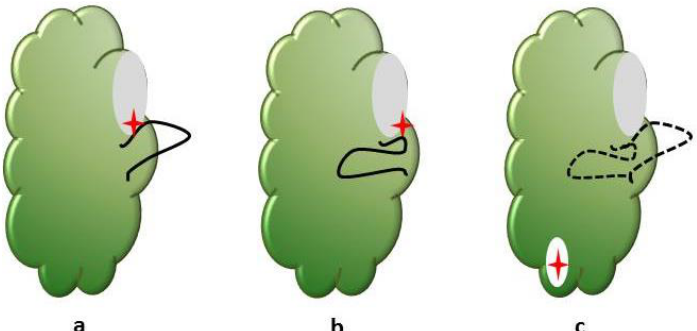
Figure 1. The activation loop of the protein kinase domain regulates access to the ATP binding site. The conformation of a conserved Asp-Phe-Gly (DFG) motif within the activation loop is used to categorize the binding mode of inhibitors. The common types of kinase—kinase inhibitor interactions include: ( a ) Type I inhibitors ( red star) bind the ATP binding site (grey) of the protein kinase domain (green). The aspartate side chain in the conserved DFG motif at the beginning of the activation loop (black) faces into the active site; ( b ) Type II inhibitors bind a flipped conformation of the DFG motif in which the aspartate side chain faces outwards; ( c ) Allosteric ligands bind to binding pockets (white) that do not overlap with the active site of the kinase. The DFG motif conformation is not important. These binding pockets can be adjacent to the active site or distant from the active